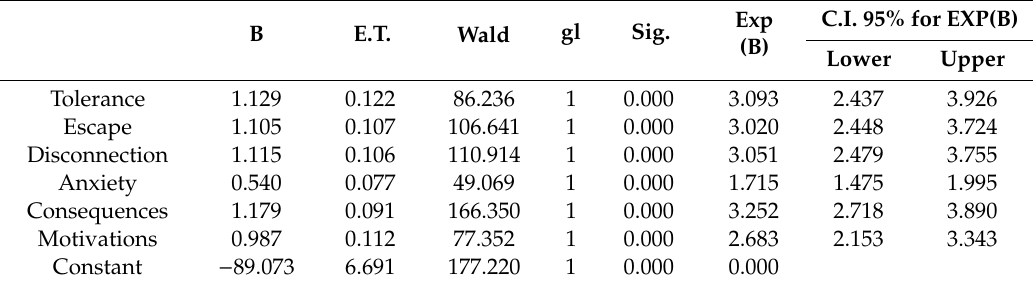
Table 4. Binary logistic regression of the self-perception on the problematic smartphone use a of Spanish and Colombian university students with respect to the MPPUSA. B E.T. Wald gl Sig.